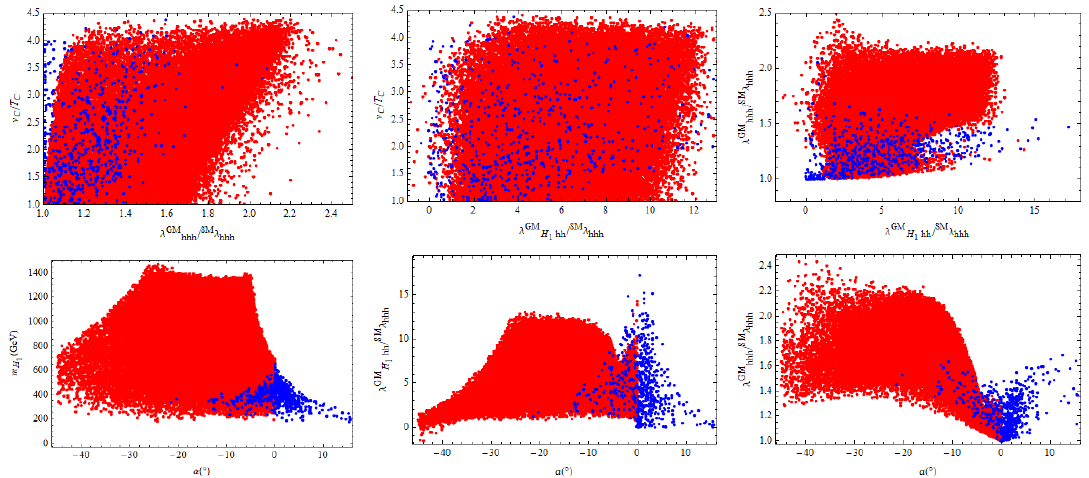
Figure 7 . The phase transition strength as a function of the triplet Higgs coupling (top-left: (cid:21) hhh , top-middle: (cid:21) H ) for one step(red points) and two step(blue points) SFOEWPT, the relation 1 hh between (cid:21) hhh and (cid:21) H is also shown in the top-right panel. In the bottom panels, the relations 1 hh between m H (left), (cid:21) H (middle), (cid:21) hhh (right) and (cid:11) are shown for one- and two-step 1 1 hh